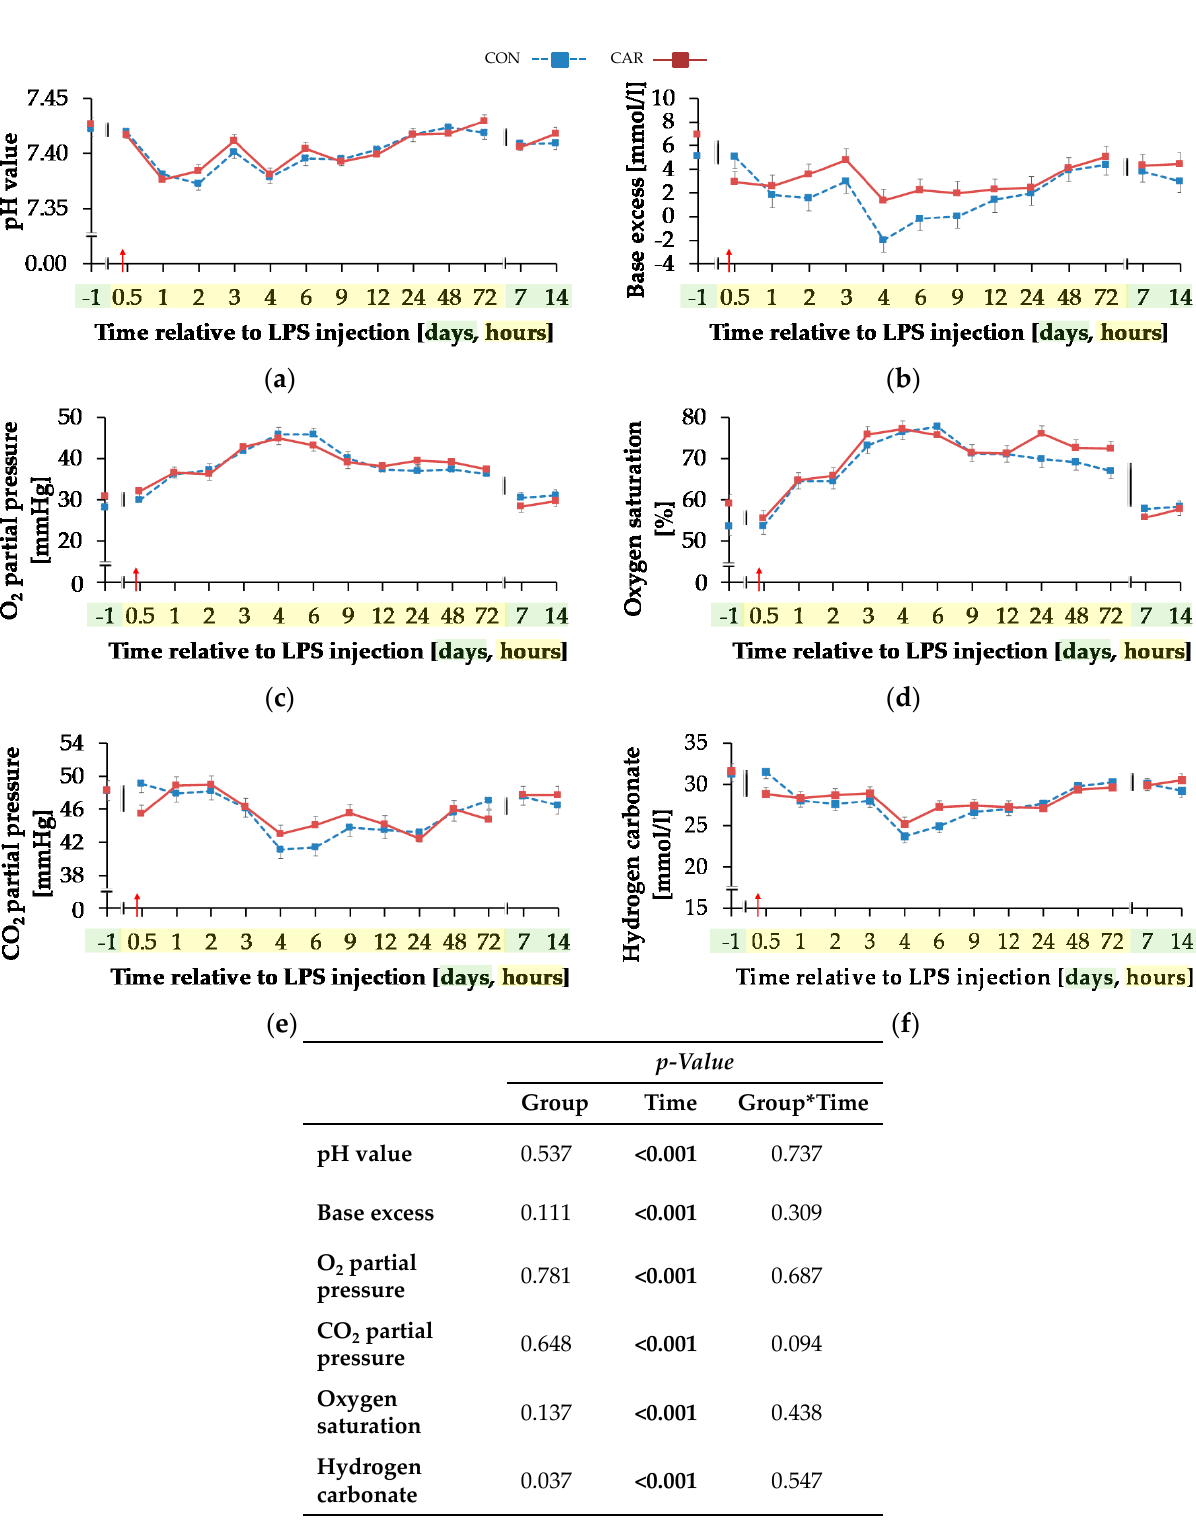
Figure 7. Progression of acute phase reaction related parameters of dairy cows fed a non-supplemented (CON) or an L- carnitine supplemented diet (CAR, 25 g/d from 6 weeks ap up to day 126 pp) before and after an intravenous injection of 0.5 μ g/kg BW lipopolysaccharides (LPS) on day 111 pp (red arrow). ( a ) Total leukocyte count, concentration of ( b ) hapto- globin and ( c ) cortisol. ( d ) Data statistics. Data are given as LS-Means standard errors. Significant p -values are marked as bold.